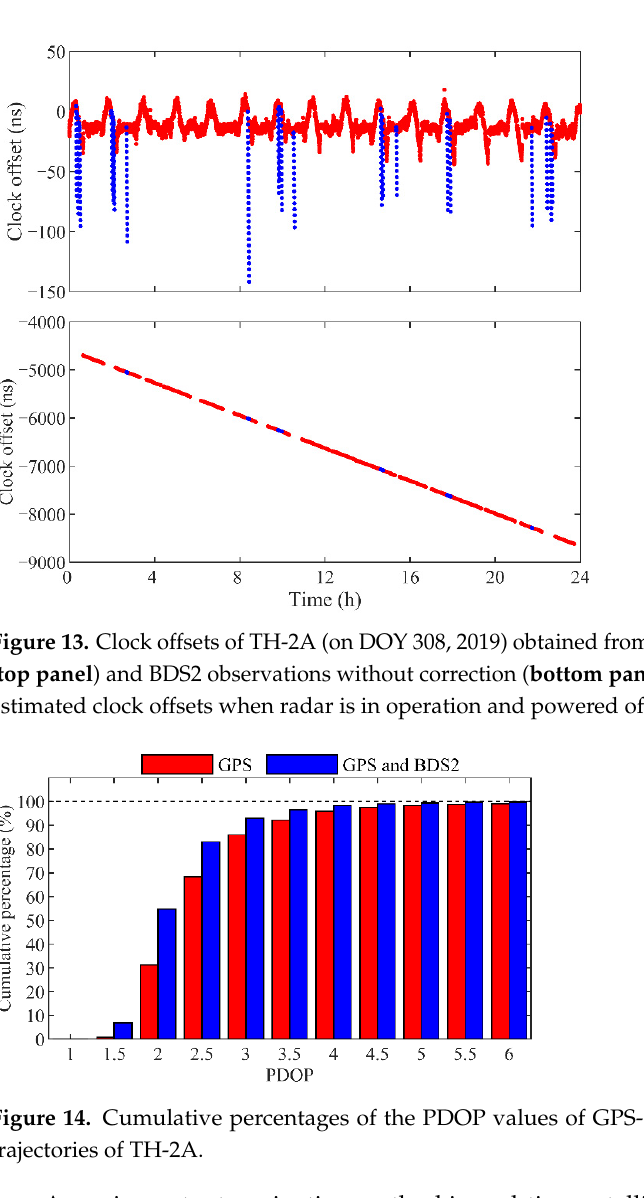
Table 5. Average RMS of orbit differences of GPS ‐ only and GC combined SPP solutions with respect to GPS ‐ based POD for TH ‐ 2A and TH ‐ 2B.